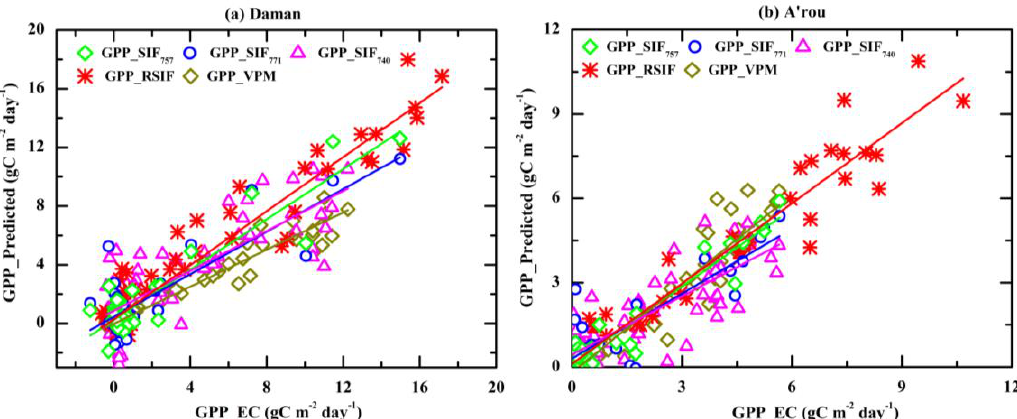
Figure 5. Relationships of the tower GPP with the GPP estimates from SIF 757 , SIF 771 , SIF 740 , and VPM at the ( a ) Daman and ( b ) A’rou sites. Table 2. Comparison between the tower GPP and model-predicted GPP. OCO-2 GPP_VPM